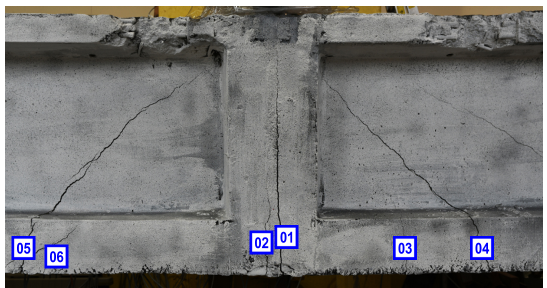
Figure 13. Numbering of the analyzed cracks [40].